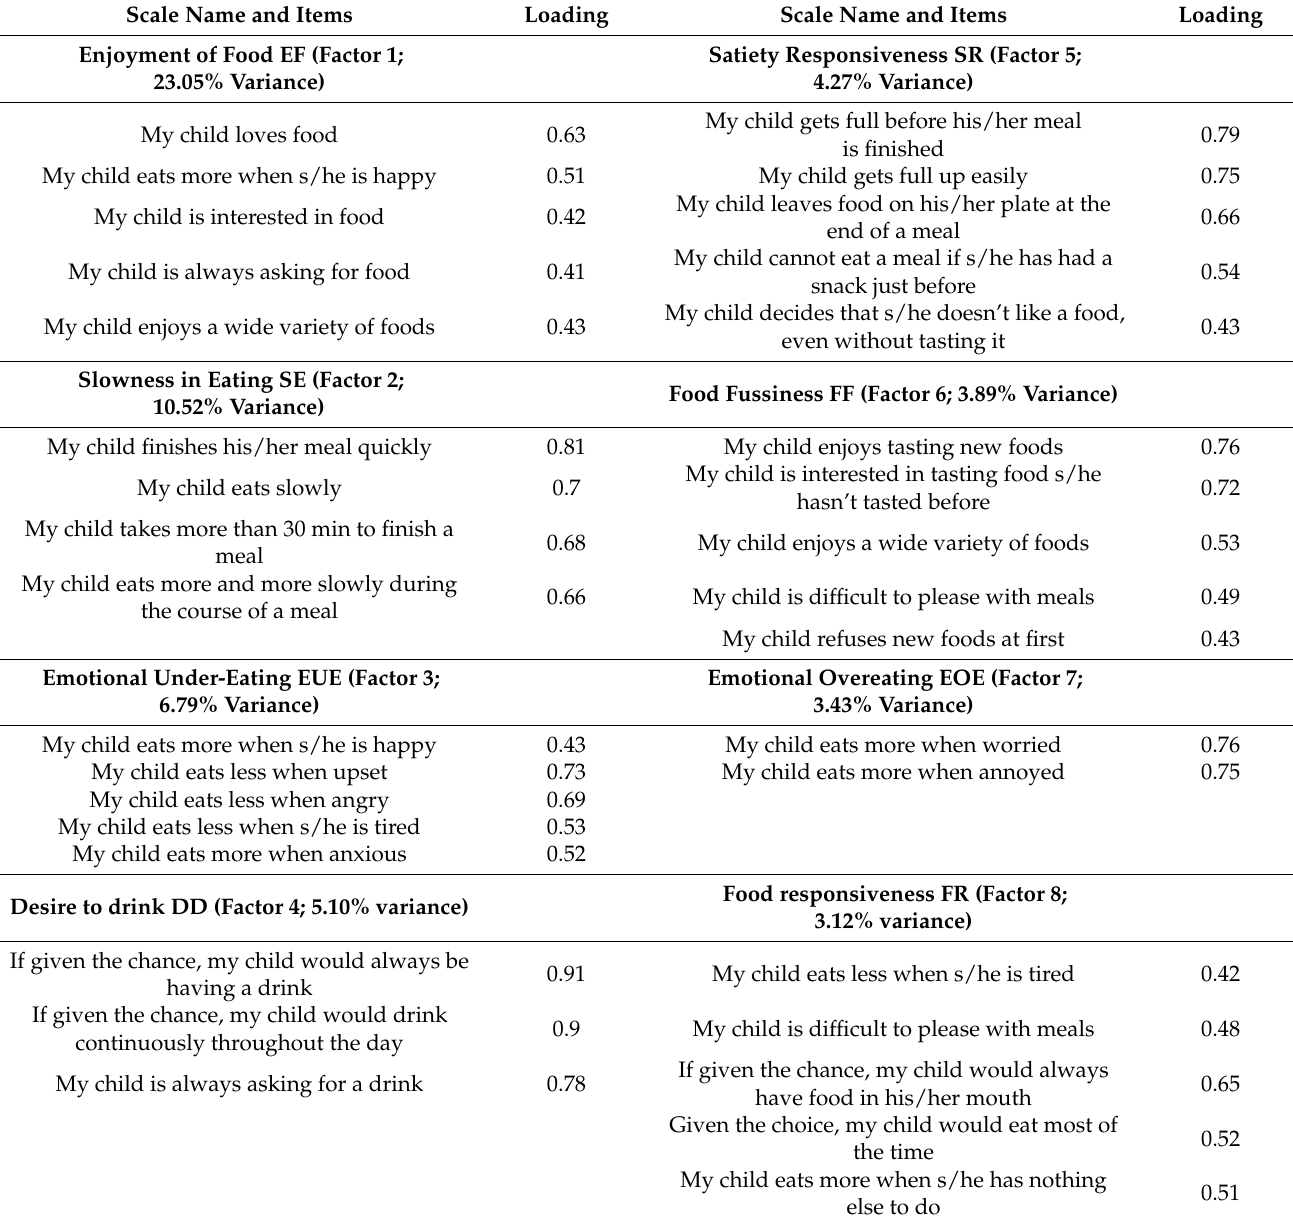
Table 2. Factor loadings on Direct oblimin rotation of Principal Components